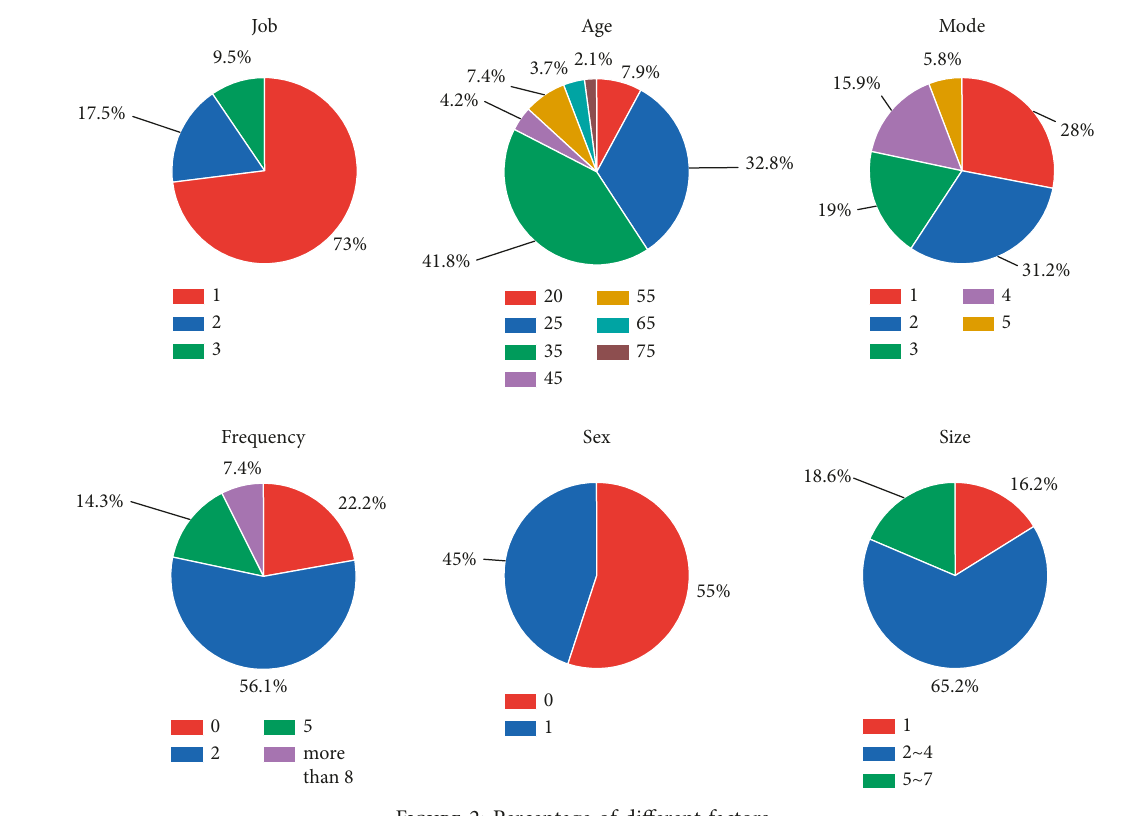
Figure 2: Percentage of different factors.